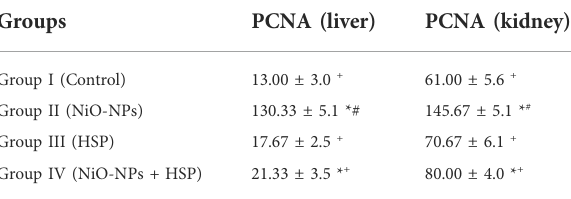
Values are presented as mean ± SD. *: Signi fi cantly different from Control group. +: Signi fi cantly different from NiO-NPs group. #: Signi fi cantly different from HSP group. Statistical signi fi cance level at p < 0.05